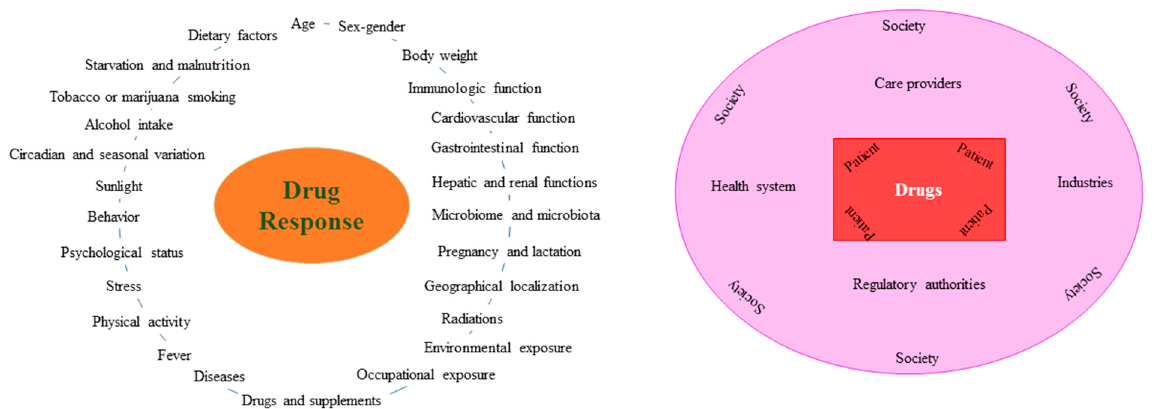
Figure 1. Factors that influence the pharmacological response. Table 2. Sex differences that can affect PK parameters in adult men and women.